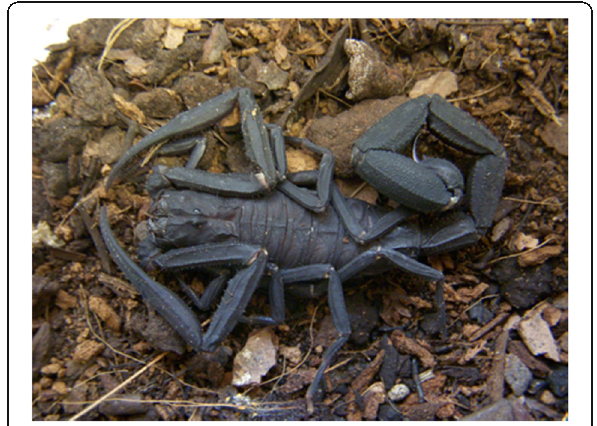
Fig. 5 Tityus fasciolatus. It is generally yellowish brown with three longitudinal bands on the dorsal side of the trunk. It can measure from 4.5 to 7 cm in length. Source: Brazilian Ministry of Health [6]. Image copyright by Denise Cândido, reproduced with